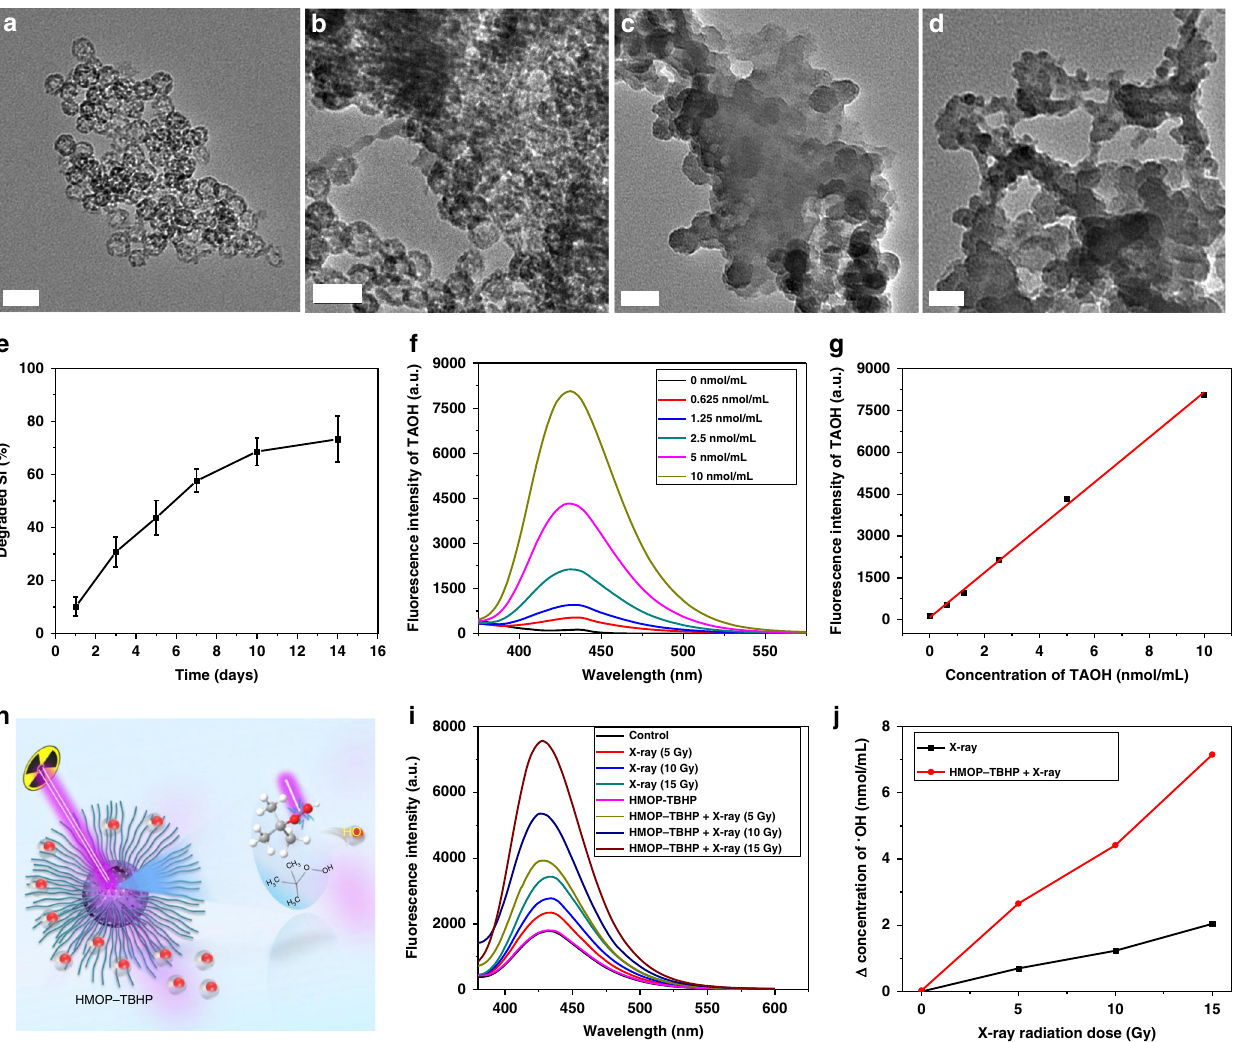
Fig. 4 Biodegradation of HMON and X-ray-activated (cid:129) OH generation. a – d TEM images of thioether-hybridized HMON dispersed in PBS with 10 mM GSH for 1 day ( a ), 3 days ( b ), 7 days ( c ), and 14 days ( d ). Scale bar: 50 nm. e Degradation curve of thioether-hybridized HMON in PBS with 10 mM GSH within 14 days. n = 3, mean ± s.d. f Fluorescence emission spectra of TAOH with different concentrations. g Standard curve for the linear relation between the concentration of TAOH and its fl uorescence intensity at λ = 430 nm. h Schematic of X-ray-activated cleavage of peroxy bond within TBHP (encapsulated in the cavity of HMOP) for generation of (cid:129) OH. i Fluorescence spectra of TAOH (oxidized TA) subjected to varied doses (0, 2, 4, 6 Gy) of X-ray irradiation with or without HMOP-TBHP. j The (cid:129) OH concentrations calculated by (cid:129) OH-triggered oxidation of TA into 2-hydroxyterephalic acid